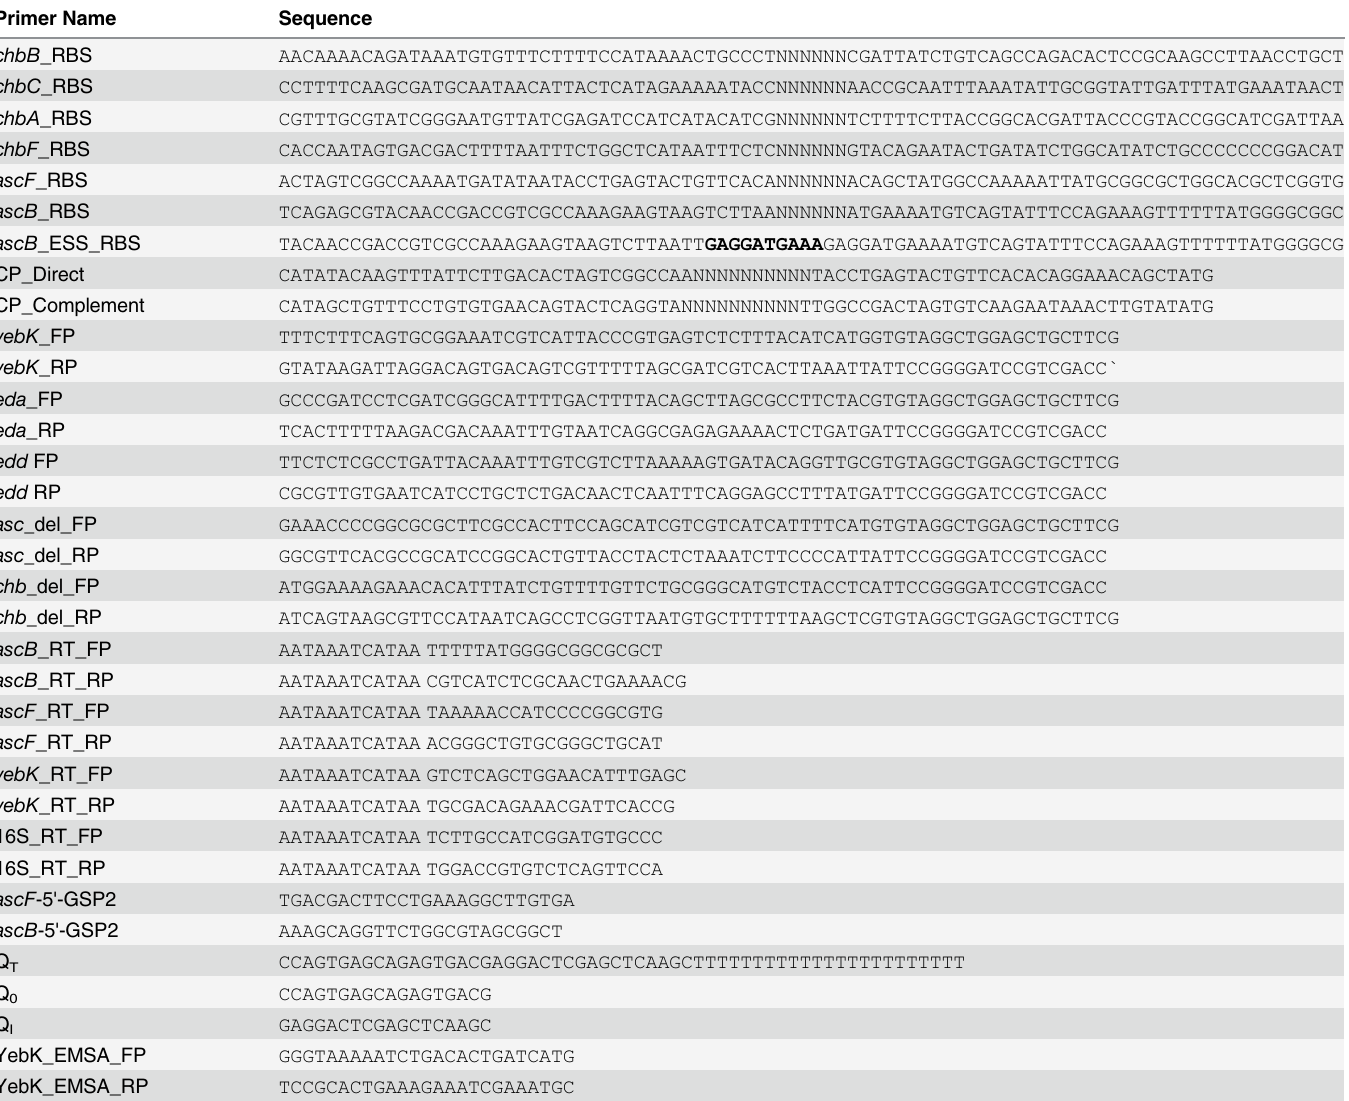
Table 2. Primers used in the study. Sequence in red indicates the duplicated nuclotide observed in strain